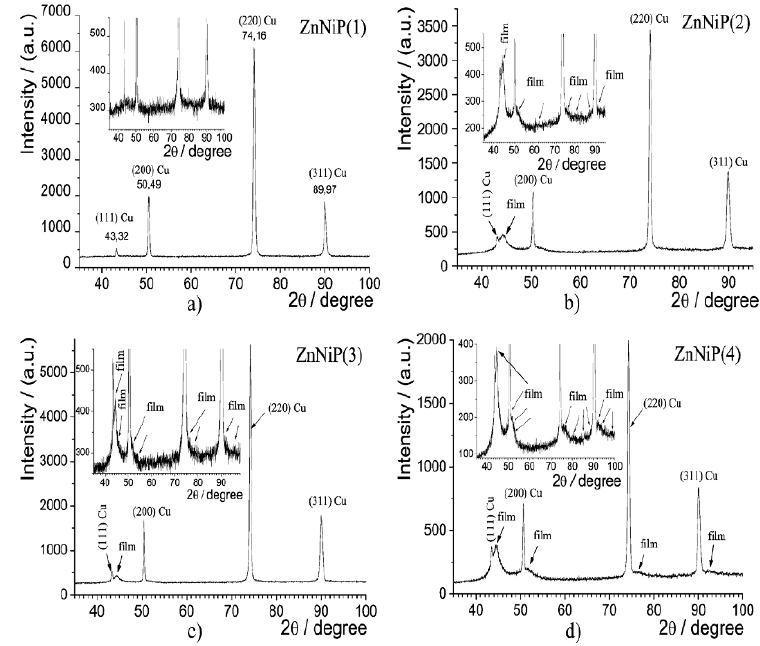
Figure 3. XRD pattern of electrodeposited Zn-Ni-P thin films: a) ZNP(1); b) ZNP(2); c) ZNP(3); d) ZNP(4).